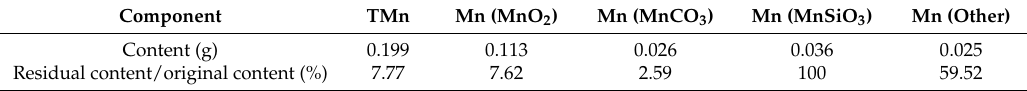
Table 2. Content of insoluble manganese phase in